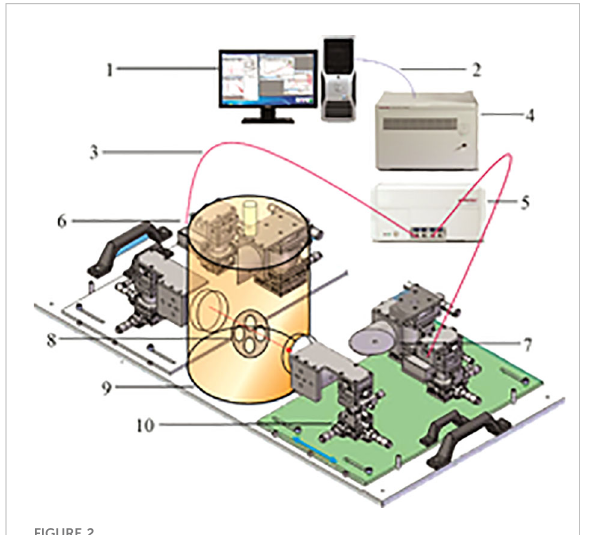
FIGURE 2 The structure and working principle of the Advantest-TS7400 THz-TDS measurement system.